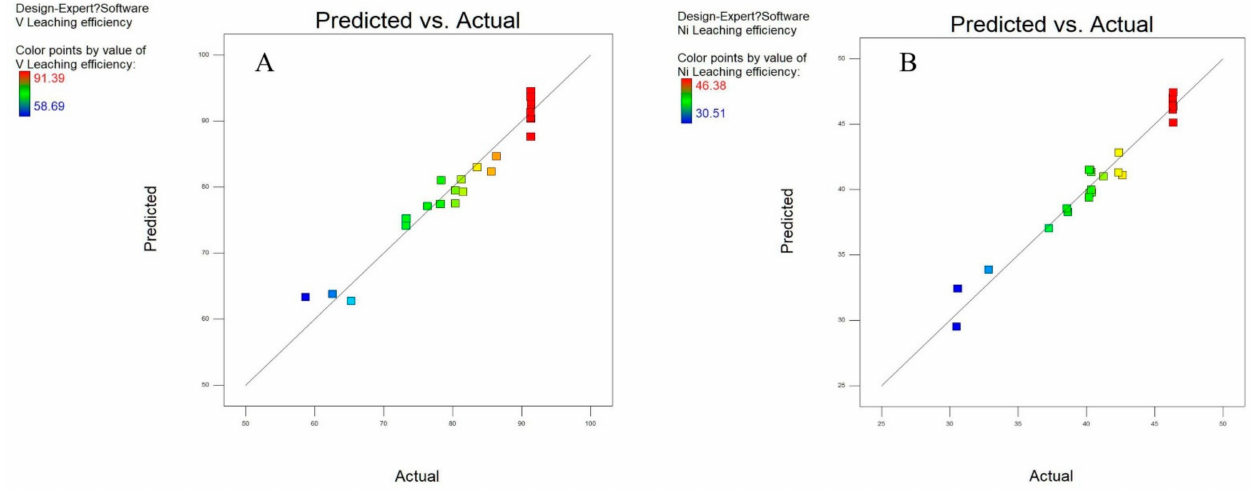
Figure 7. Diagnostic plots of quadratic model. (( A ) Predicted v/s the Actual values for V; ( B ) Pre- dicted v/s the Actual for Ni).